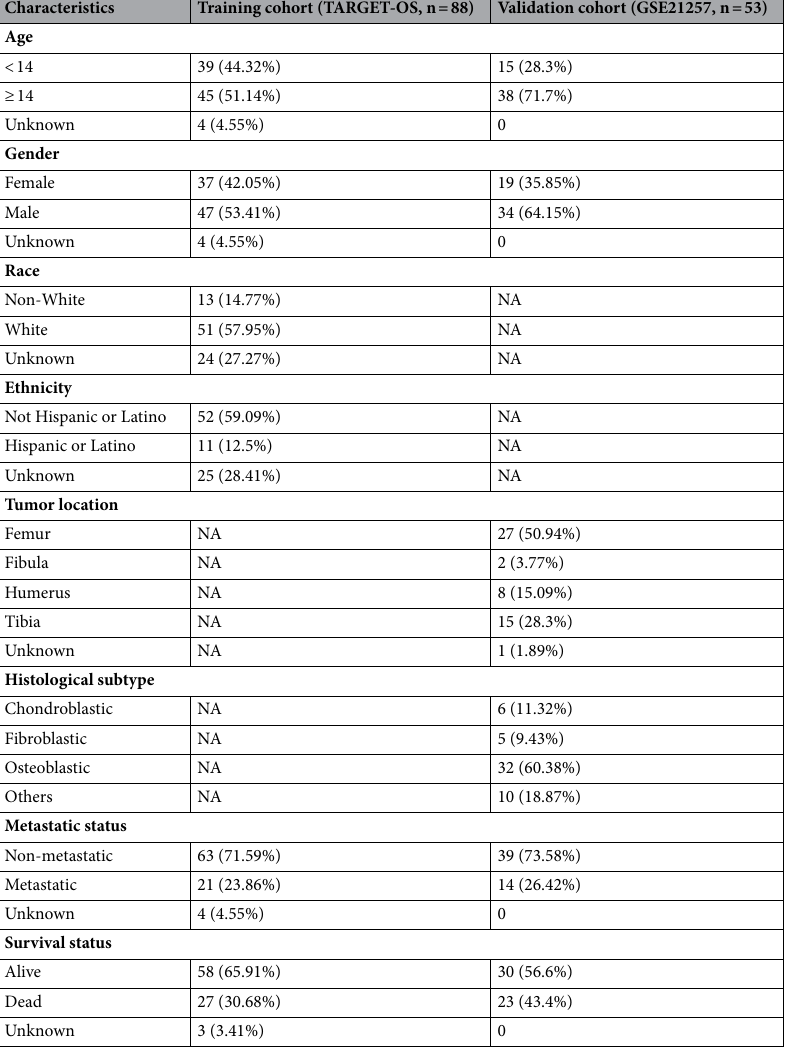
Table 1. Clinical characteristics of patients involved in the